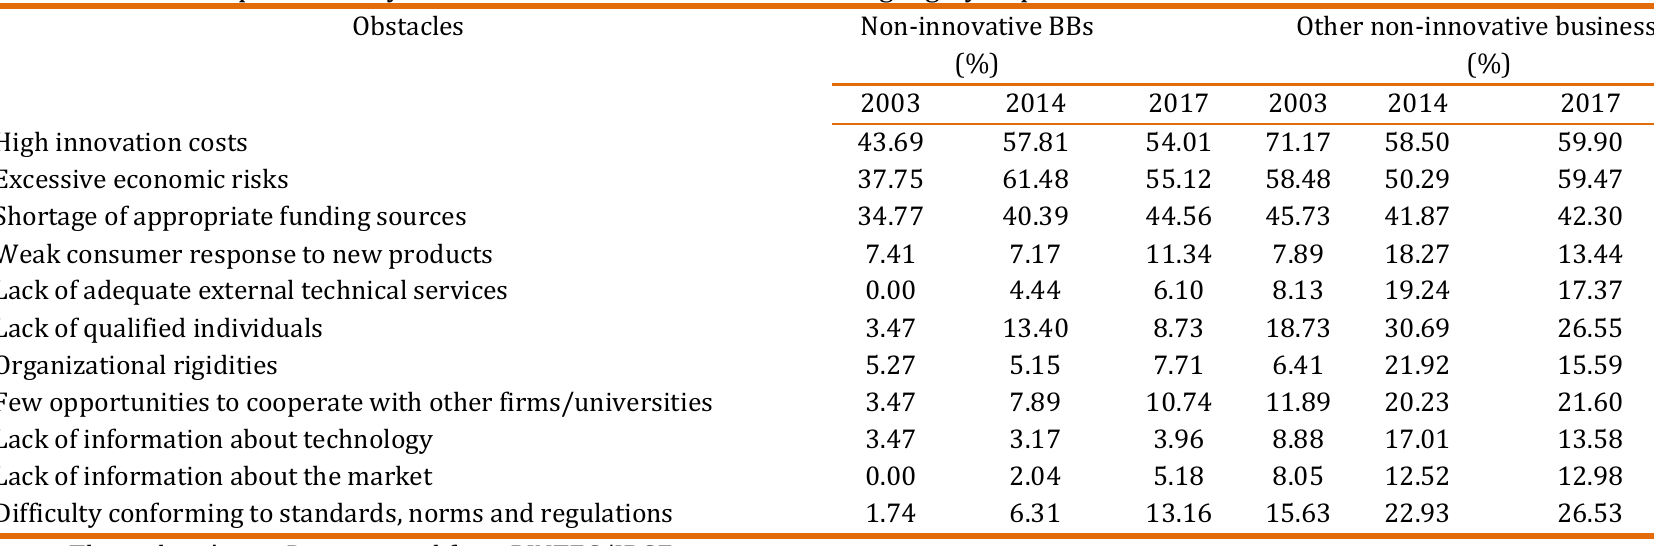
Table 07 . Obstacles perceived by non-innovative Brazilian BBs as being highly important, 2003, 2014 and